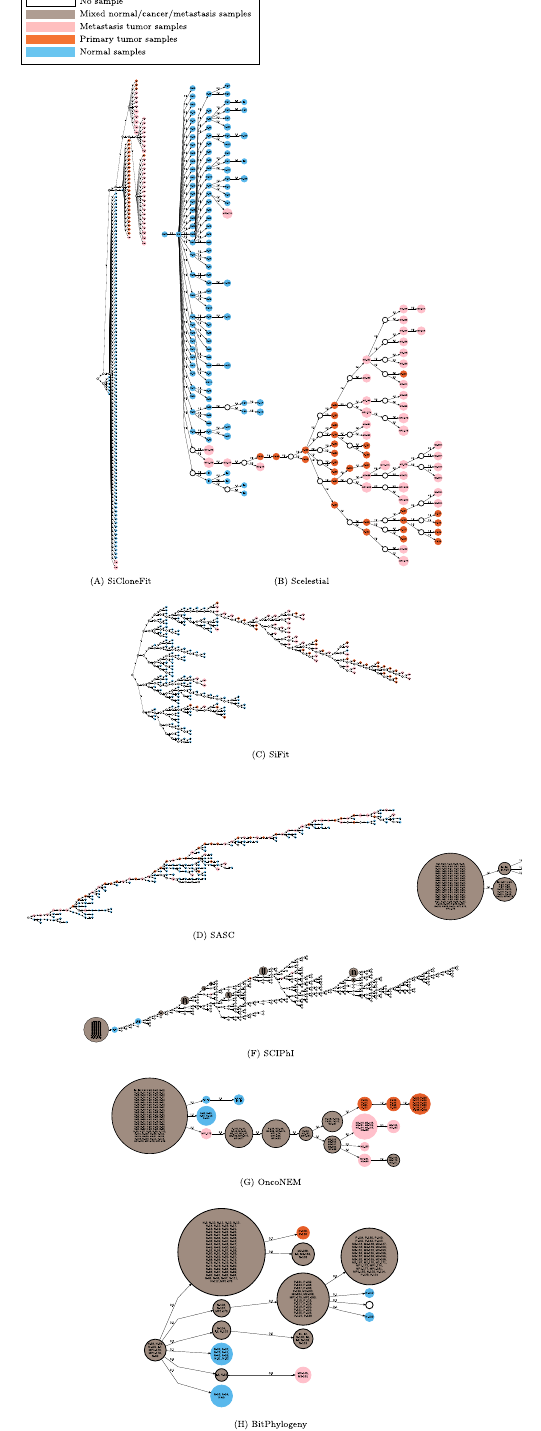
Fig 6. Lineage tree inferred by the different methods on a single-cell dataset from the second colorectal cancer patient.